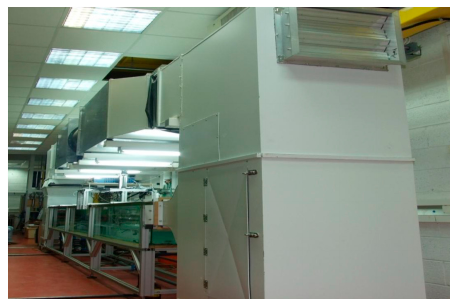
Figure 1. General view of the experimental facility in the TAU Water Waves Laboratory.